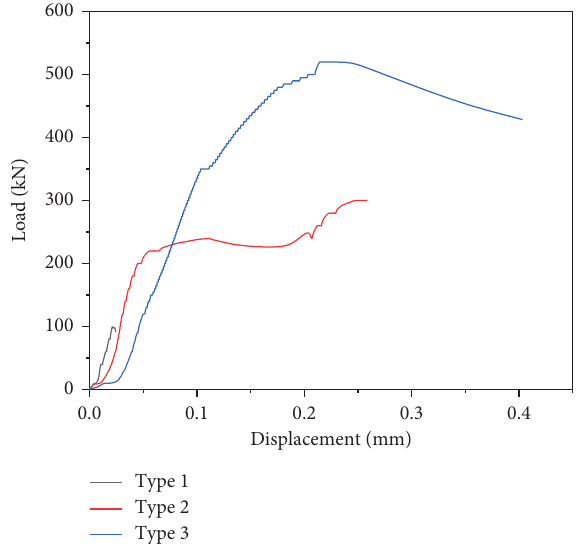
Figure 11: Load-displacement